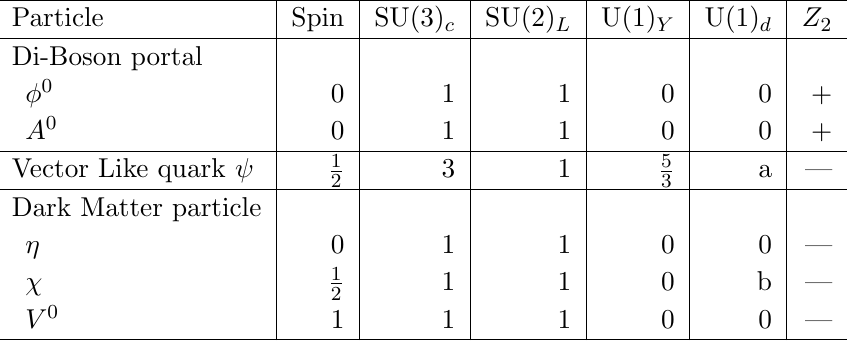
Table 1. Quantum number assignments of new scalars, pseudo-scalar, vector-Boson and fermions of the dark U(1) d sector under the gauge symmetry group SU(3) C (cid:2) SU(2) L (cid:2) U(1) Y (cid:2) U(1) d